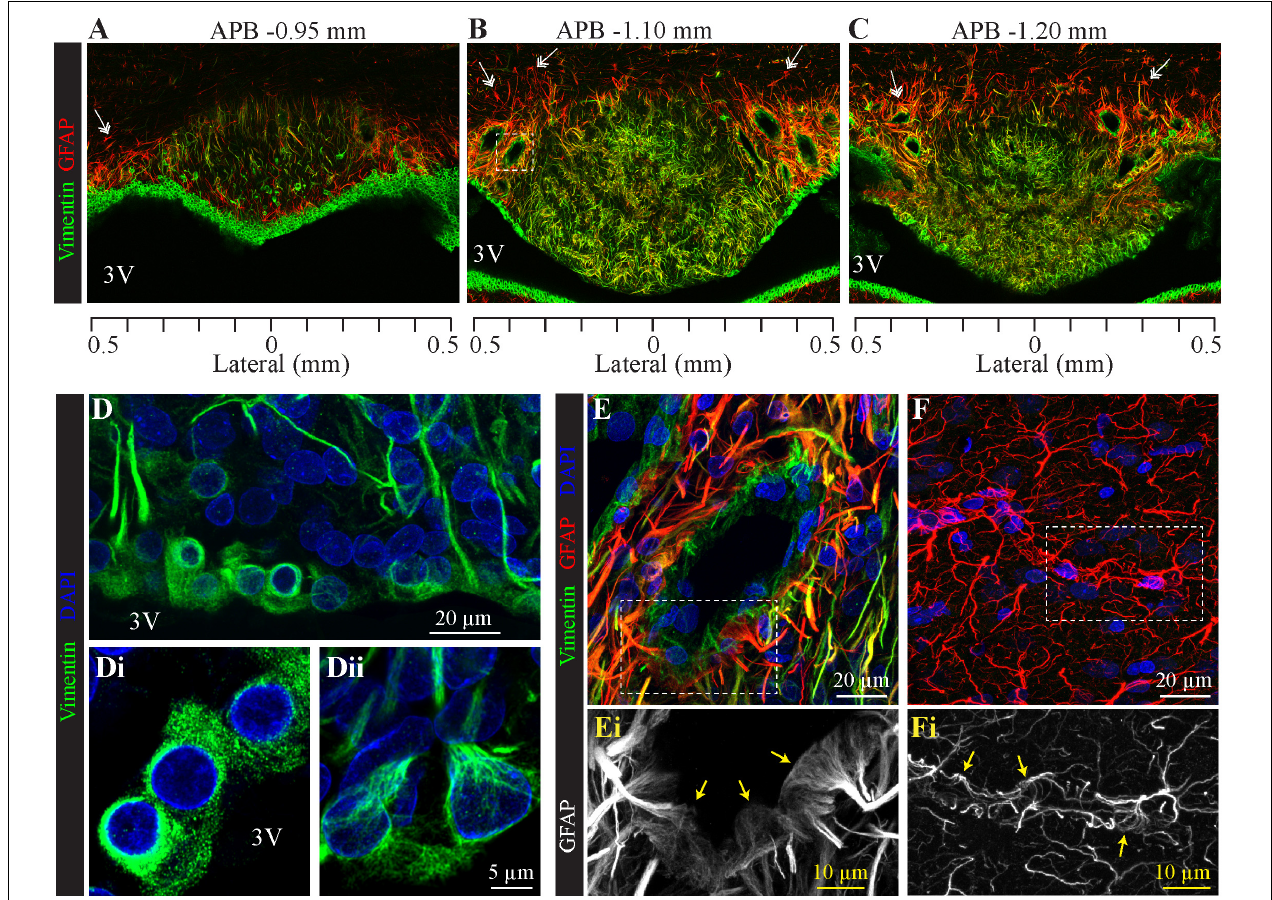
FIGURE 3 | Distribution of SFO ependymocytes, tanycytes, and astrocytes in the coronal plane. Immunohistochemical staining of glial fibrillary acidic protein (GFAP, red) and vimentin (green) in serial coronal sections of SFO corresponding to APB coordinates –0.95, –1.10, and –1.20 mm, respectively (A–C) . Note GFAP-positive classical stellate astrocytes are only present in the lateral shell of the SFO (double arrow). (D) High magnification images of the section in panel (B) showing the ventricular wall created by cell bodies of ependymocytes (Di) and tanycytes (Dii) , (vimentin green, DAPI blue). (E,F) Images of non-fenestrated blood vessels located in the SFO [ (E) , magnification of area outlined by dotted square in panel (B) ], and outside the SFO [ (F) , cortex], labeled for GFAP (red), vimentin (green) and DAPI (blue). Note that non-fenestrated vessels in the SFO are contacted by GFAP-positive and vimentin-positive processes, while cortical vessels are lacking vimentin processes. Areas outlined by dotted lines in panels (E,F) are magnified below illustrating GFAP-positive end feet contacting SFO (Ei) and cortical (Fi) non-fenestrated blood